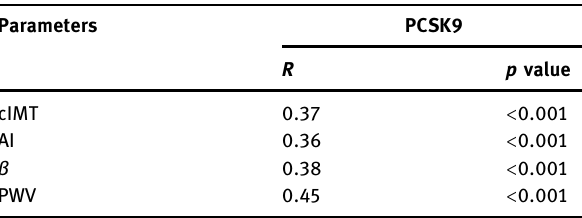
Table 4: Correlations between the subclinical vascular changes and PCSK9 concentrations Parameters PCSK9